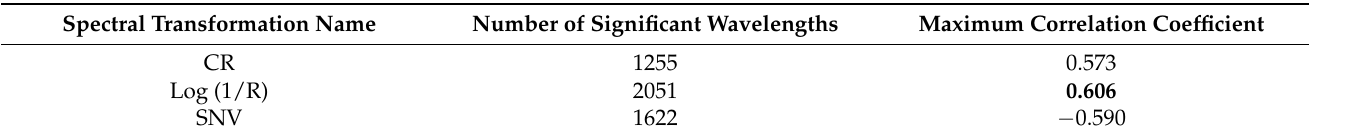
Table 2. The number of wavelengths passing the significance test ( p < 0.01) and the maximum correlation coefficient for different spectra.